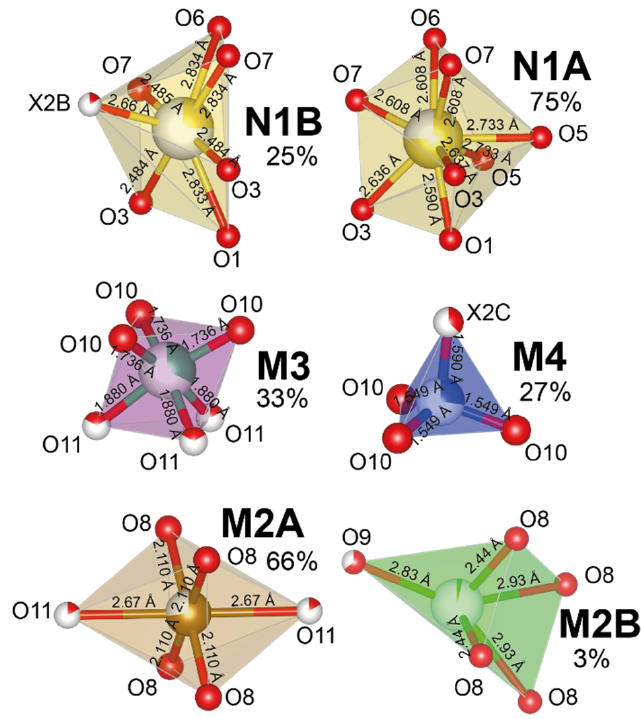
Figure 4. The local coordination and occupancy of the split sites in the crystal structure LV-153/178 EGM sample.